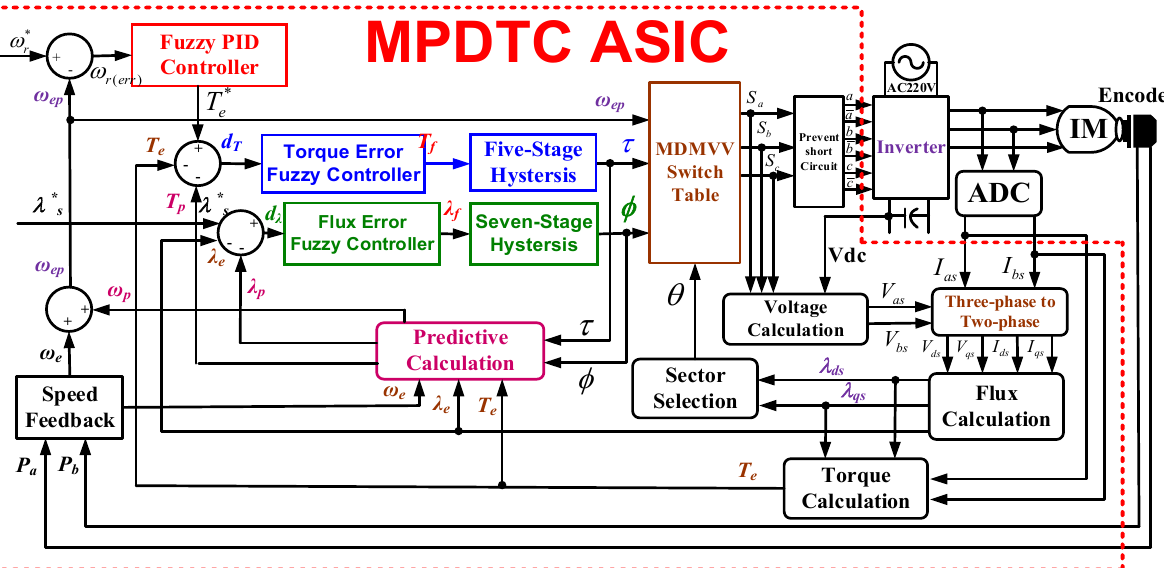
Figure 1. Block diagram of the proposed MPDTC ASIC with fuzzy seven-stage hysteresis and a fuzzy PID controller for s a three-phase IM drive system.